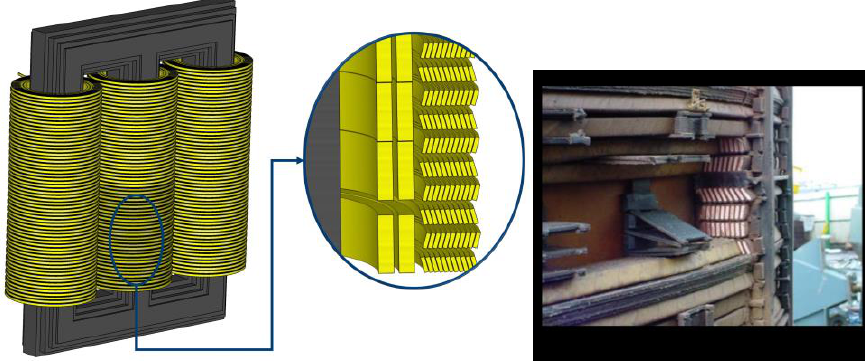
Figure 20. Representation of conductor tilting failure mode in the HF model ( left ) and 275/132-kV 240-MVA autotransformer [22] ( right ).